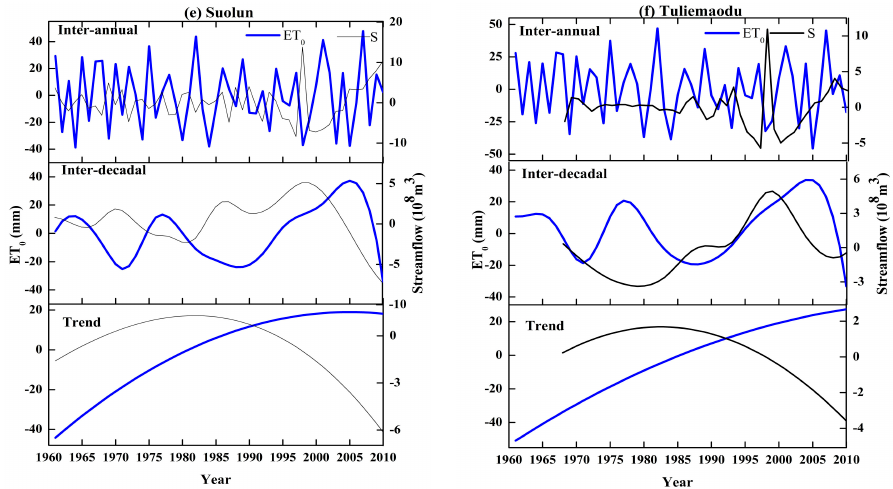
Figure 7. Nonlinearity of streamflow (S) at six gauge stations (( a ) Beian, ( b ) Shihuiyao, ( c ) Xiaoergou, ( d ) Zhalantun, ( e ) Suolun and ( f ) Tuliemaodu) to potential evapotranspiration (ET 0 ) during 1961–2010 in the headwater region of the Nenjiang River Basin, Northeast China. Table 2. Streamflow (S), temperature (T), precipitation (P) and potential evapotranspiration (ET 0 ) at six gauge stations on different time scales during 1961–2010 in the headwater region of the Nenjiang River Basin, Northeast China.